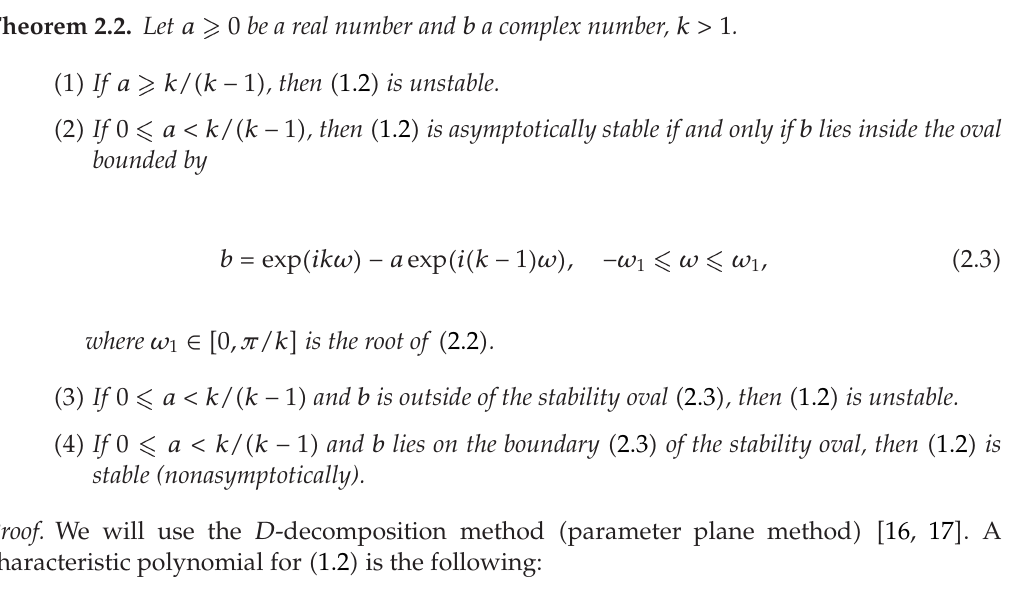
0, k (cid:3) (cid:0)